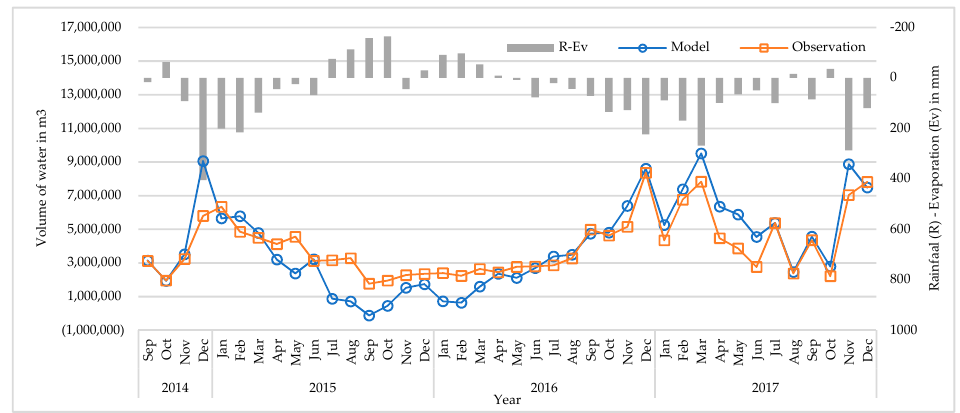
Figure 13. Simulation model validation.